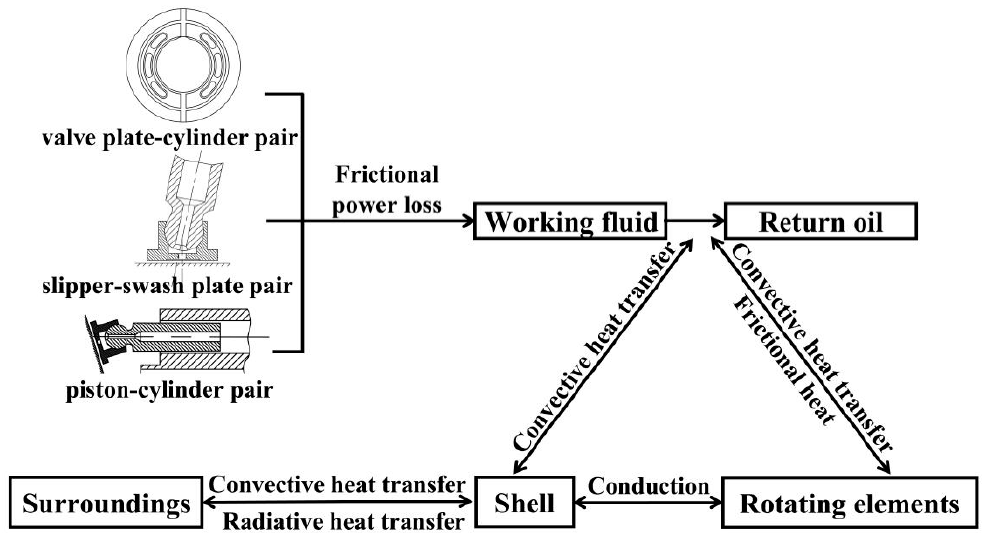
Figure 3. A schematic diagram of the heat transfer path.